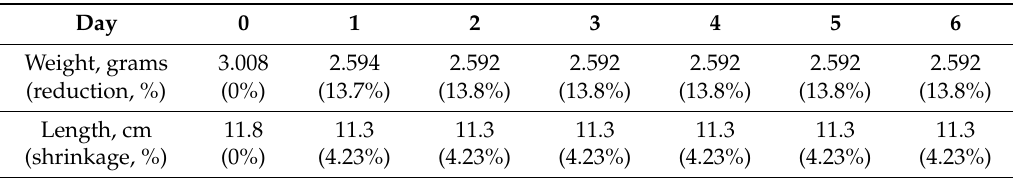
Table 2. Weight and size variations of manufactured parts with time.